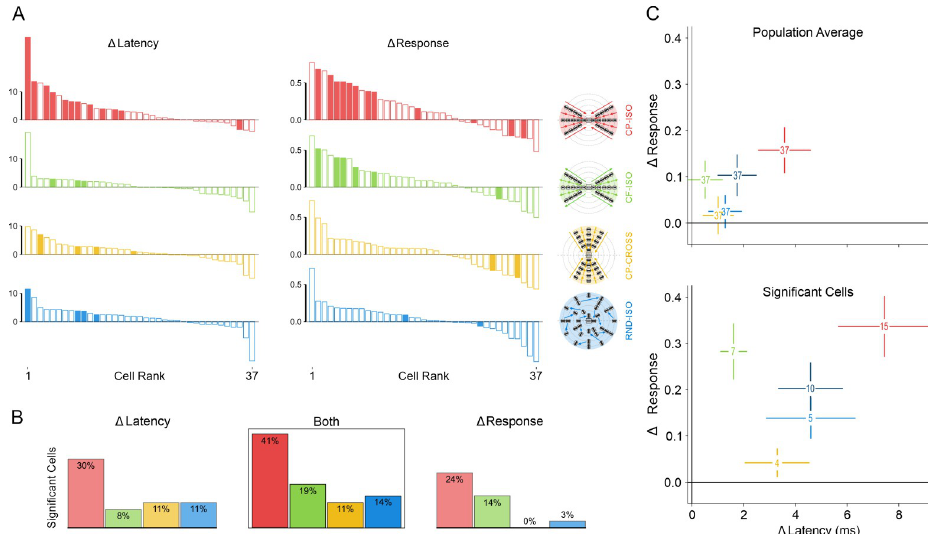
Fig 7. Statistical significance of contextual response changes. Color code, same as in Fig 1C, schematized by icons in the middle column. SECTOR configuration: red for CP-ISO, green for CF-ISO, gold for CP-CROSS; dark blue for RND; FULL configuration: pale blue for RND-ISO. ( A): Top left panel, ranked amplitude distributions (n = 37) of changes in latency (ms, left column) and in response integral value (normalized ratio, right column) of subthreshold responses (Vm), for each SECTOR AM condition of interest (first three rows). The fourth row corresponds to the FULL-RND condition (see Text for justification). Ordinates: latency shortening and integral response increase are plotted upward. Abscissa: cell rank (1 to 37) ordered independently for each AM condition. Filled bars represent “significant” individual cases (one-sided permutation test, 104 repetitions, p < 0.05). Ordinates: left column, latency change (“ Δ Latency”) measured at half-height of the Center-Only peak response; right column, change in the integral value of “significant” depolarizing responses ( ± 3 σ from mean Vrest), integrated to the point of return to baseline of the Center-only test control. The integral value change (“ Δ Response“) is expressed as a normalized ratio relative to the Center-Only test response. (B): Bottom left panel, each of the three histograms represents the proportions of significant cases for each AM flow condition. Left, " Δ latency" criteria. Right: “ Δ Response”criteria. Center inset (BOTH): all cases showing either a significant latency advance, or response integral increase, or both. (C): Right panel: Bihistogram of the Δ (response_integral) in ordinate vs. Δ (latency_change) in abscissa, averaged across conditions. Numbers and SEM correspond to values calculated across the whole population (upper plot) or restricted to the pool of “significant” cells (lower plot). Note that the global separability between CP-ISO and all other test conditions increases when restricting the pooling to the “significant” cells. The impact of each AM configuration is expressed in Fig 7A by ranked amplitude distribu- tions of latency changes (left column) and response integral changes (right column), relative to the Center-Only condition. The proportions of significant facilitatory effects correspond to the number of occurrences where significant positive modulations relative to this common refer- ence were observed. Paired comparisons between each condition (condition of interest and other controls) were also done but not illustrated for sake of clarity. The left histogram in Fig 7B represents the proportion of “significant” latency advance cases (upwards filled bars in the left column of Fig 7A). It is three times larger for the CP-ISO condition (30%, red column) than for the other conditions. The right histogram in Fig 7B represents the proportion of “sig- nificant” response integral changes. The facilitation effect (positive Δ Integral) is less selective across conditions, but remains specific of the collinear configuration, since most significant cases are found in both CP-ISO and CF-ISO conditions (respectively red and green). The mid- dle histogram inset in Fig 7B shows the impact of pooling both change criteria in a non-exclu- sive way (logical “OR”): the proportion of significant facilitation cases (latency shortening OR Response Integral increase) peaks for the CP-ISO condition (41%, red histogram bar in the bottom center inset), while remaining two times larger than for the CF-ISO condition (19%,